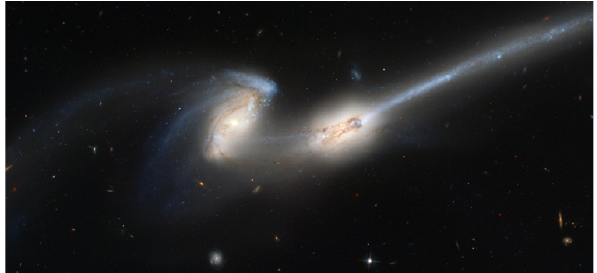
Figure 11. Hubble Space Telescope image of anomalous galaxy NGC